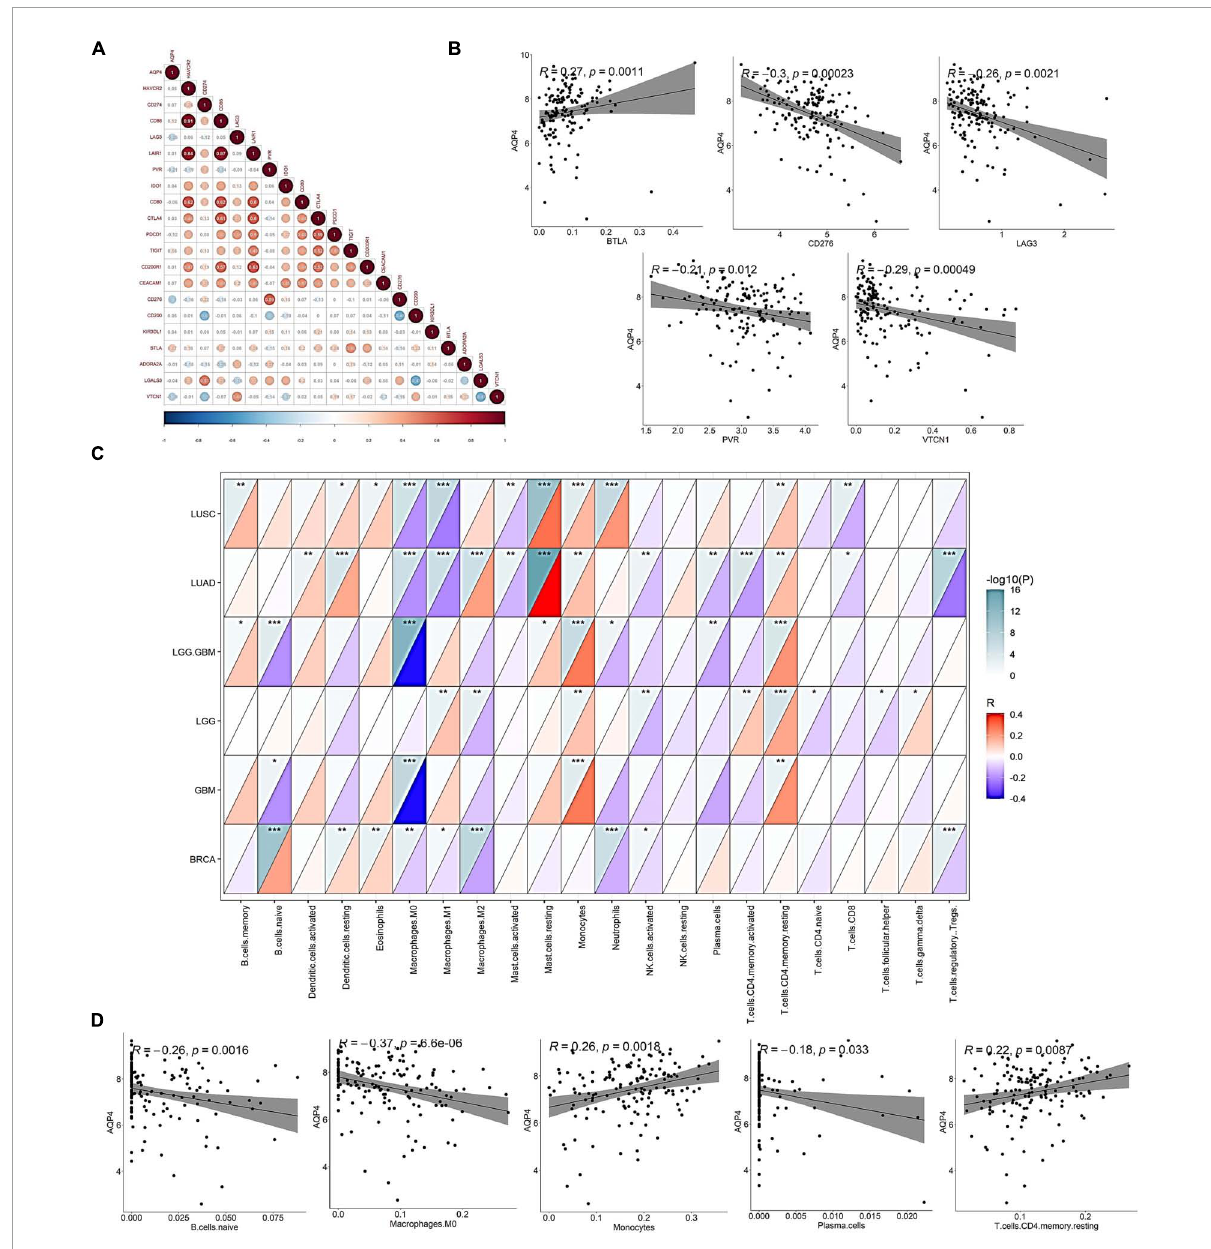
FIGURE2 Correlation of AQP4 gene with mainstream immune checkpoints and immune infiltrating cells. (A) Association analysis of the gene AQP4 with 20 immune checkpoints. (B) Correlation analysis of AQP4 gene with mainstream immune checkpoints CD276, LAG3, PVR, BTLA, and VTCN1. (C) Correlation analysis of AQP4 gene with immune infiltrating cells in pan-cancer. (D) Correlation analysis of AQP4 gene with immune infiltrating cells, B cells. Naive macrophages M0, plasma cells, T-cells, CD4, memory, resting, and monocytes. * p < 0.05, ** p < 0.01, *** p <